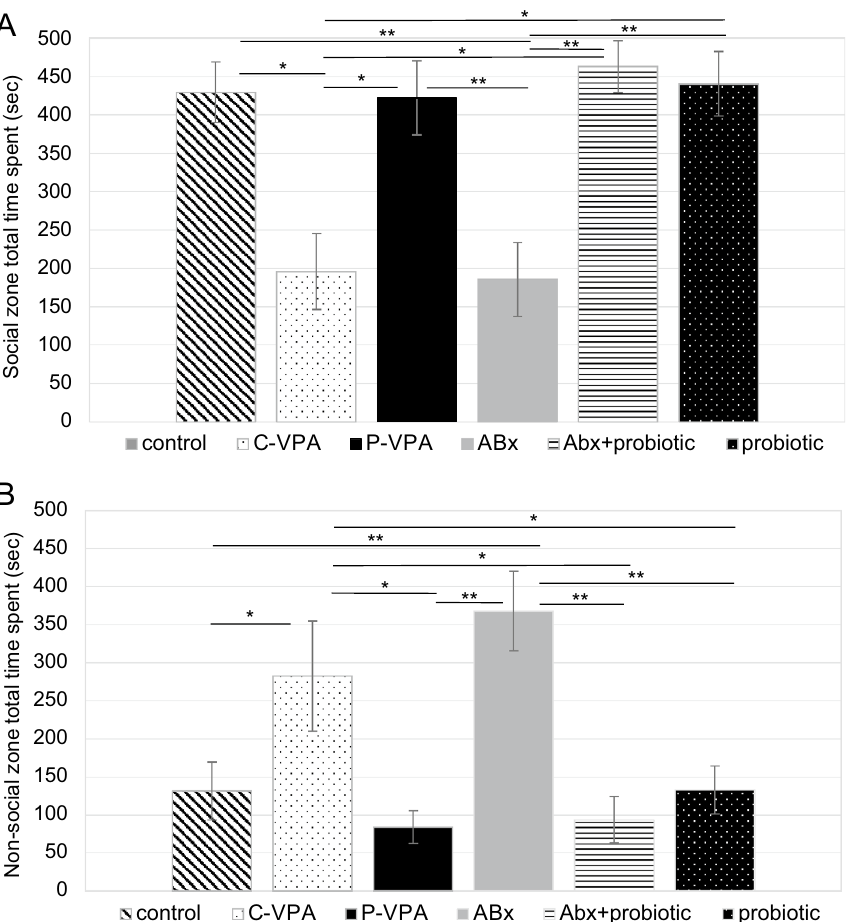
Figure 2. Time spent with the social- ( A ) and non-social ( B ) zone exploration (s) in the three chamber social interaction test. Control: control group; C-VPA: valproic acid treated group; P-VPA: valproic acid and probiotic treated group; ABx: broad-spectrum antibiotics treated group, ABx + probiotic: broad-spectrum antibiotics- and probiotic treated group, probiotic: probiotic treated group. One-way ANOVA (* p < 0.05;** p < 0.01). Data graphed as mean ±